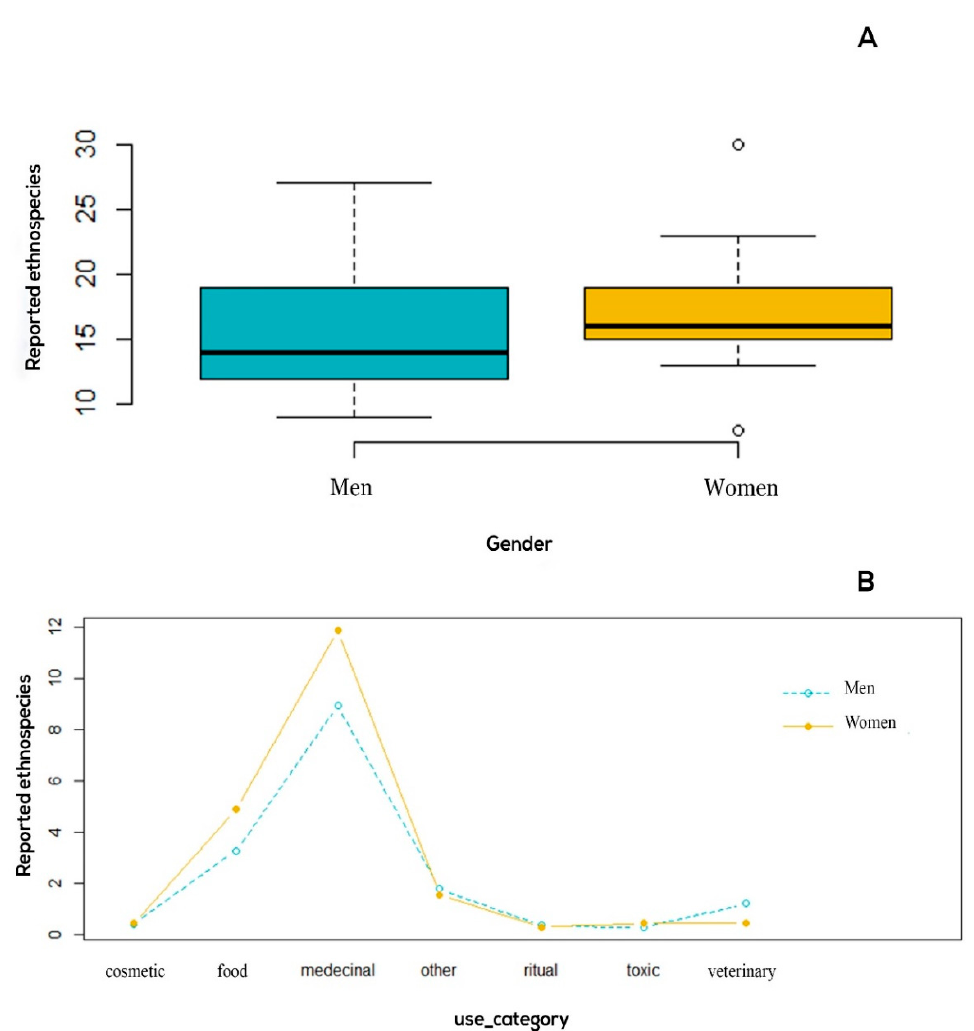
Figure 4. ( A ) Number of cited ethnospecies variations according to use category and gender obtained from the ANOVA analysis. ( B ) Informants competence according to the number of ethnospecies he/she mentioned by gender.